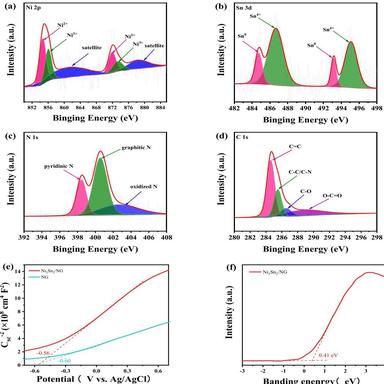
High resolution XPS spectra of Ni 2p (a), Sn 3d (b), N 1s (c) and C 1s (d) in Ni3Sn2/NG. (e) Mott–Schottky plots of Ni3Sn2/NG and NG. (f) XPS valence band spectrum, (g) Kubelka–Munk plot, and (h) band diagram for Ni3Sn2/NG. (i) Photographs and (j) UV/Vis spectra of Li2S6 solution before (A) and after adding NG (B) and Ni3Sn2/NG (C).